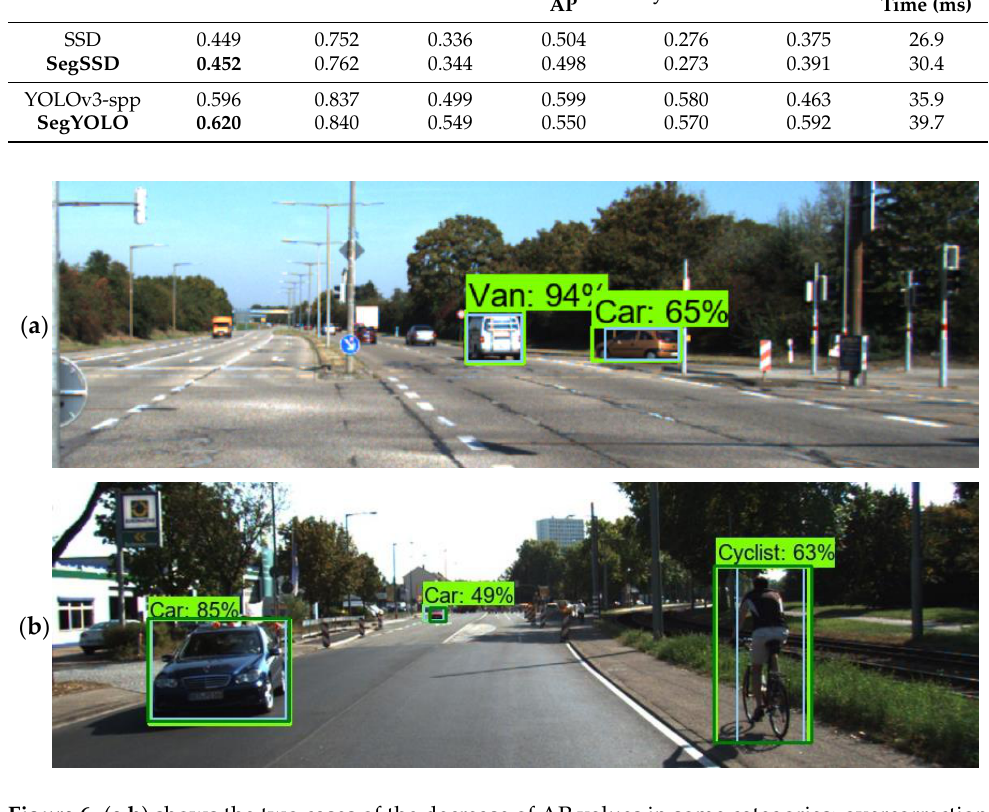
Figure 6. ( a , b ) shows the two cases of the decrease of AP values in some categories: overcorrection and better than ground truth, respectively. The yellow-green bounding boxes indicate the output of YOLOv3spp, the bright blue indicates the output of SegYOLO, and the blackish green boxes indicate the ground truth of annotation.